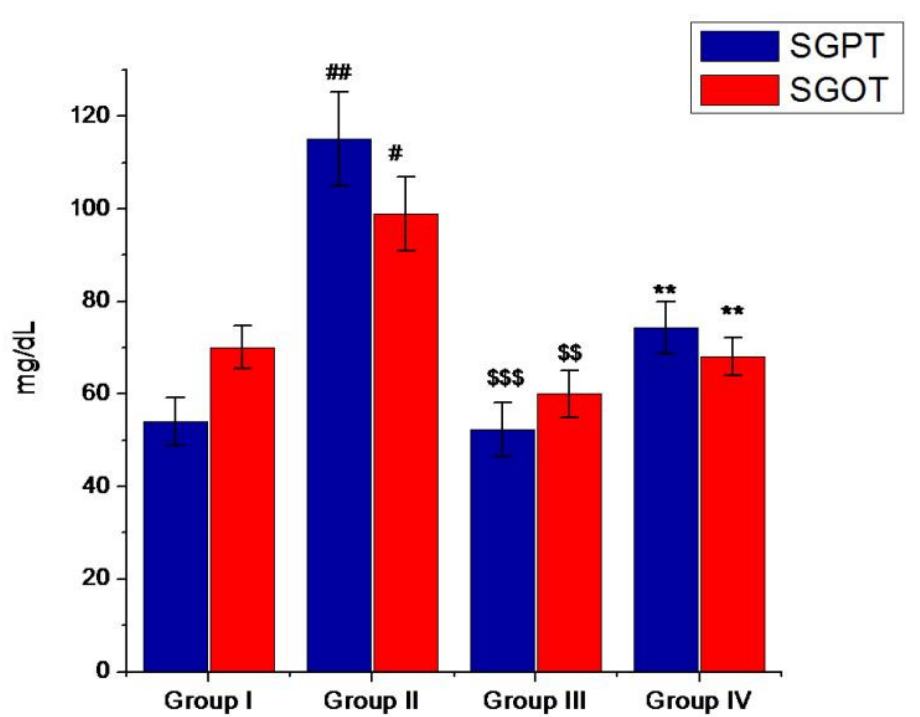
Figure 10. Levels of SGPT and SGOT (mg/dl) of various study groups. Group-I; normal control, Group-II; diabetic left untreated, Group-III; diabetic treated with glibenclamide, Group-IV; diabetic treated with mino/AgNPs. ‘#’ indicates a significant difference between the control and diabetic groups; ‘$’ indicates a significant difference between the diabetic and glibenclamide treatment groups; ‘*’ indicates a significant difference between the diabetic and mino/AgNPs treatment groups. Each bar represents the value of mean ± SD of eight replicates. Statistical icons: # = p ≤ 0.05; ##, $$, ** = p ≤ 0.01; $$$ = p ≤ 0.001.